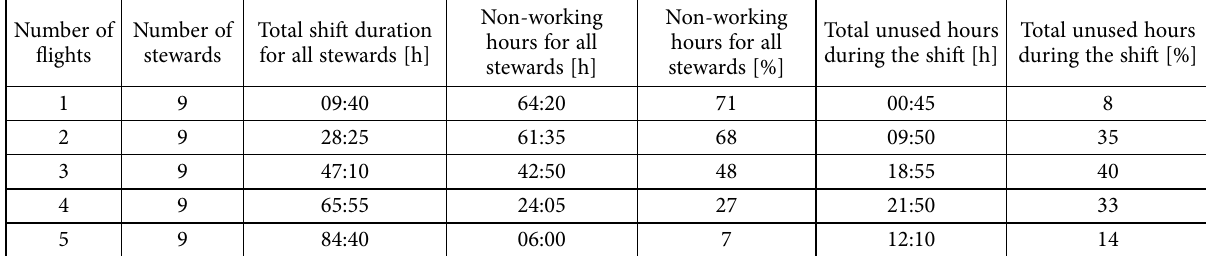
Table 9. Summary results for instances of 1 to 5